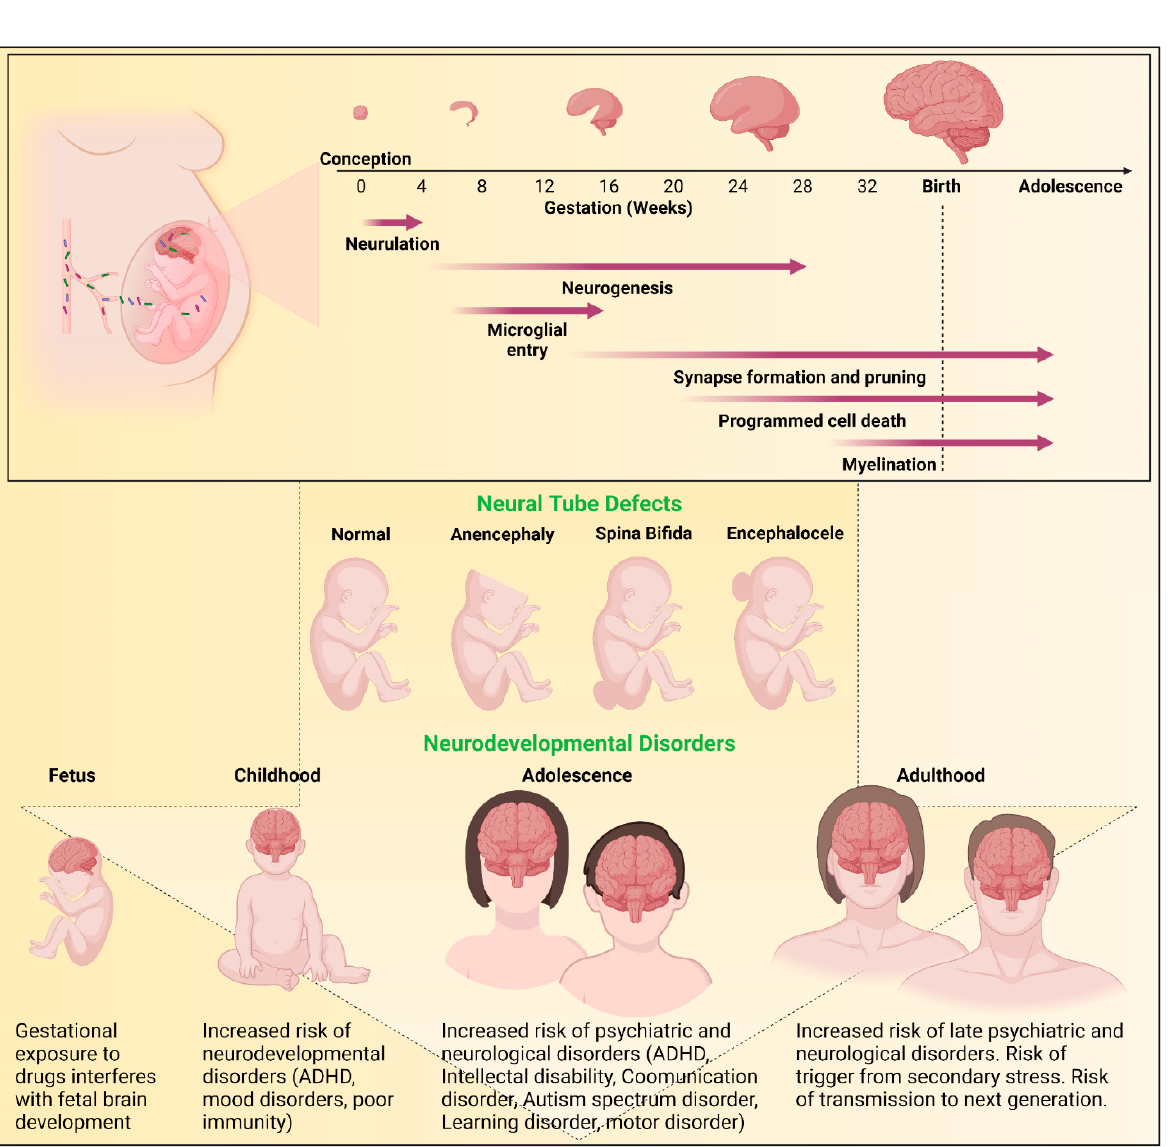
Figure 2. Outline of brain development and risks of neurodevelopmental disorders. The